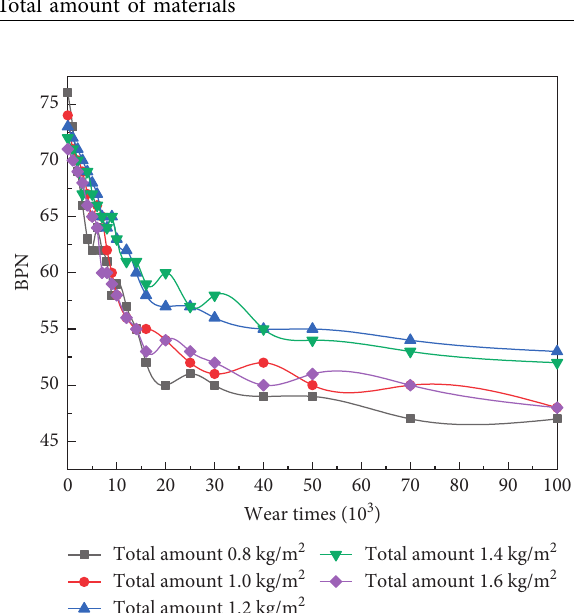
Figure 17: BPN abrasion law of specimens.